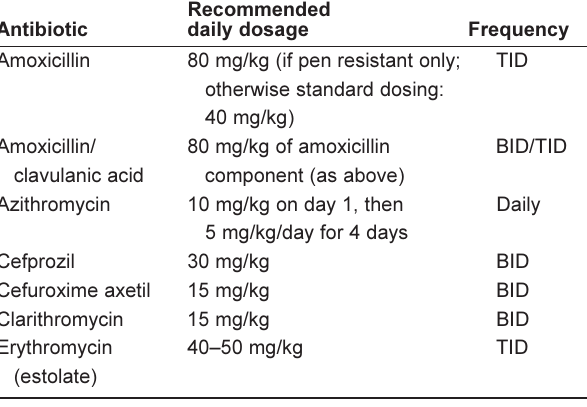
TABLE 3 Antibiotic dosage regimens for outpatient treatment of pneumonia in